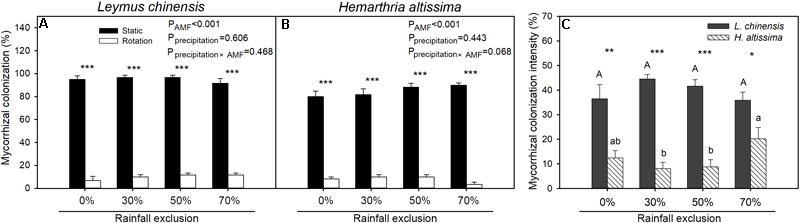
The percentage of arbuscular mycorrhizal fungi (AMF) roots colonization (F%) in L. chinensis
(A) and H. altissima
(B), and the intensity of mycorrhizal colonization (M%) (C). Different lowercase and capital letters indicate significant differences (P < 0.05) among the rainfall exclusion treatments in H. altissima and L. chinensis, respectively. ∗∗∗P < 0.001, ∗∗P < 0.01, and ∗P < 0.05 indicates differences between L. chinensis and H. altissima. Data are reported as mean ± 1 SE (n = 4).